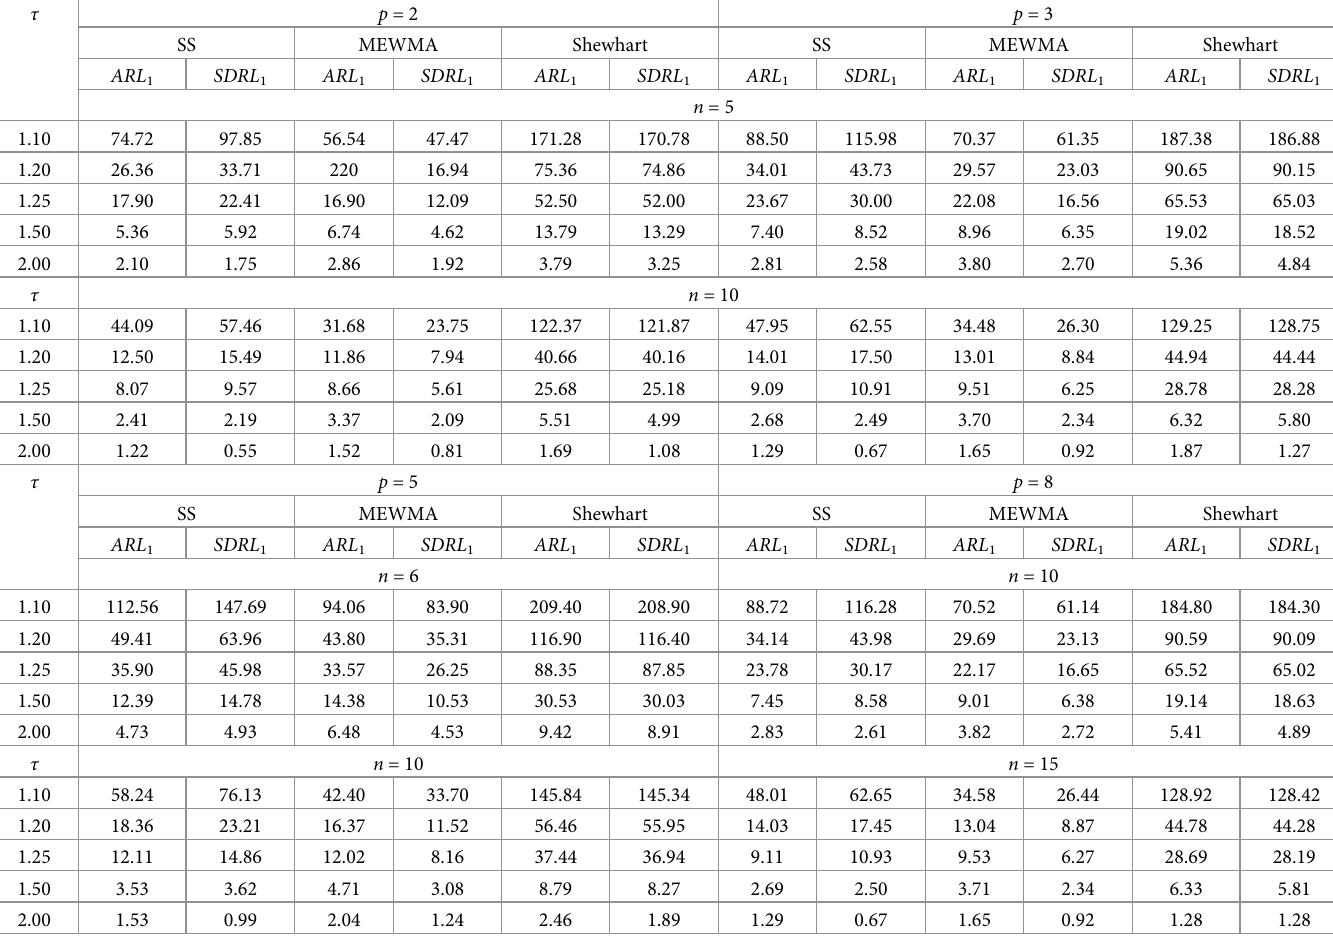
Table 6. A comparison of the ARL1 and SDRL1 of the multivariate SS chart with the MEWMA and Shewhart γ charts for γ 0 = 0.10, p 2 {2,3,5,8}, n 2 {5,6,10,15} and